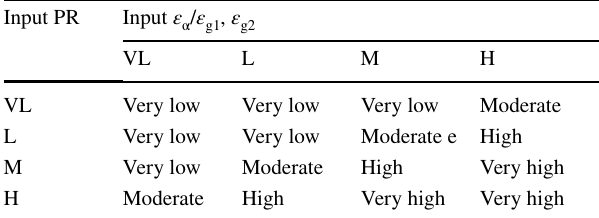
Table 4 Rule base in inference Mamdani model coupling input and output variables